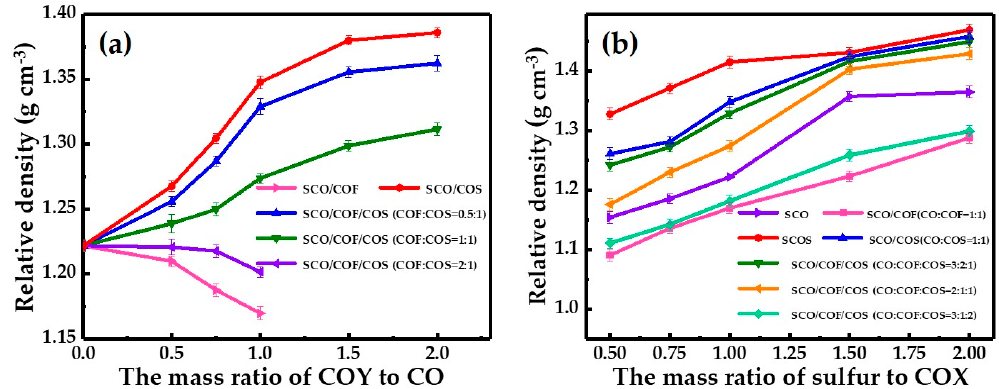
Figure 4. Relative density of the prepared samples. ( a ) Relative density variation in samples versus the mass ratio of COY to CO (m S / m COX = 1); ( b ) relative density variation in samples versus the mass ratio of sulfur to CO, COF, COS and their mixture, including CO / COF, CO / COS, as well as CO / COF / COS (COX).